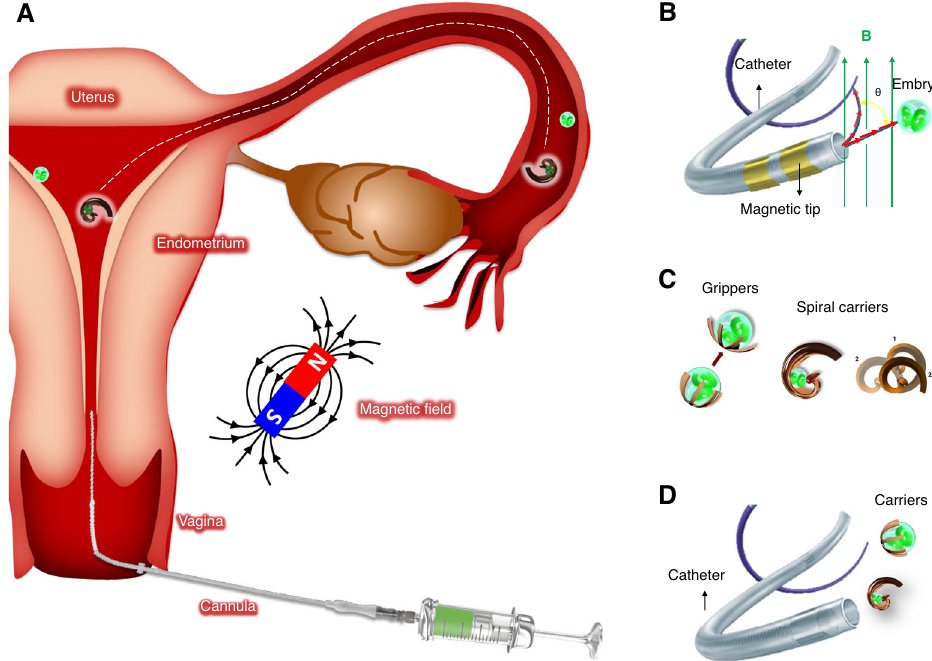
Fig. 1 | Case study — microrobotic embryo transfer or µ ZIFT. A Conceptual depictionofaspiral-likemicromotorthatisusedtocapture,transport,andrelease anoocyteorembryointhefallopiantubeandendometrium.Overviewofstrategies